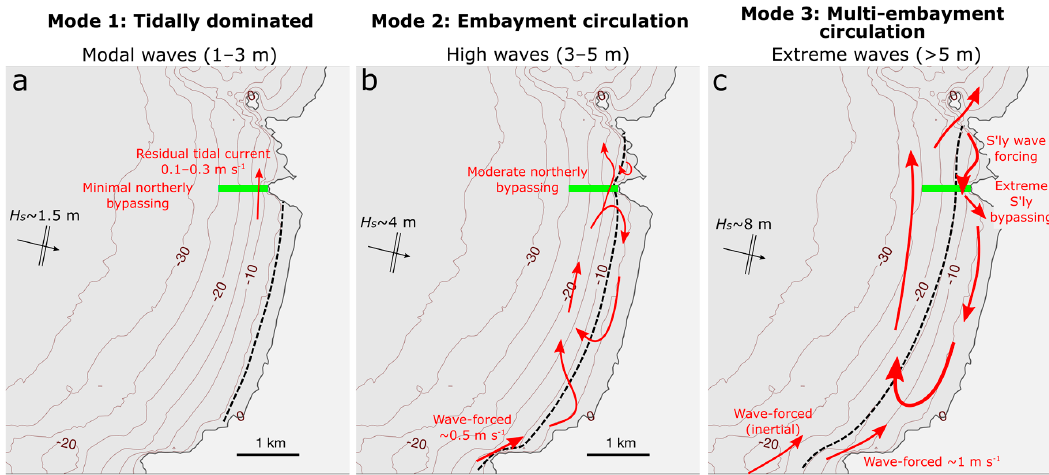
Figure 11. Idealised modes of embayment circulation. The red lines indicate currents. The sediment flux will generally follow current streamlines, but sediment availability may restrict transport in some regions. The green line is the transect T1 , used in the analysis. The black dashed line indicates the seaward edge of the surf zone.